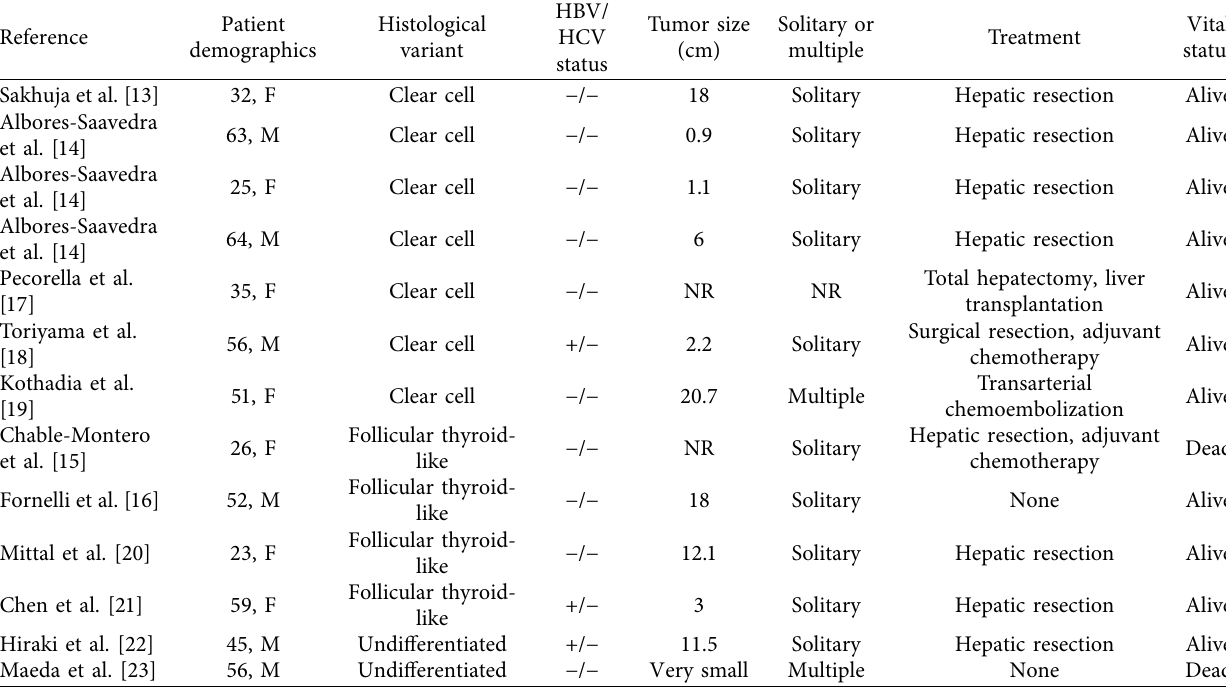
Table 1: Summary of selected prior case reports of liver cancer with rare histological